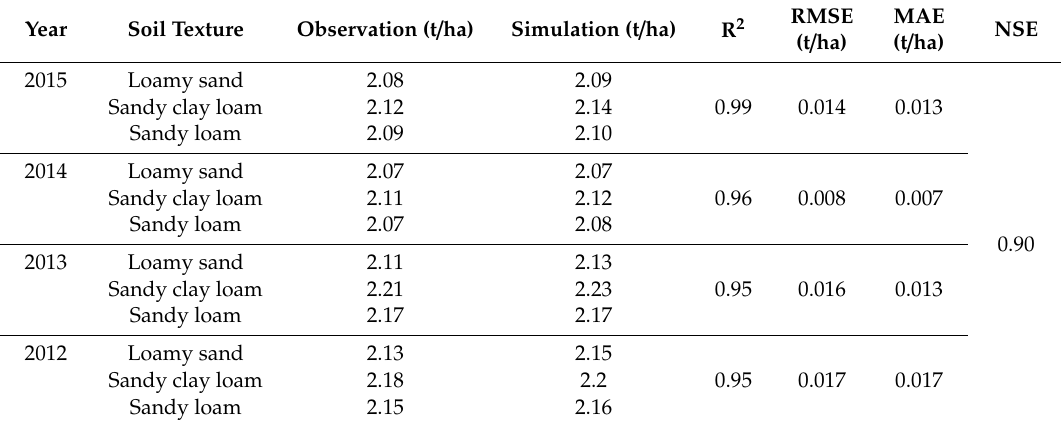
Table 5. Model evaluation of simulated maize yield in various soil textures for four growing